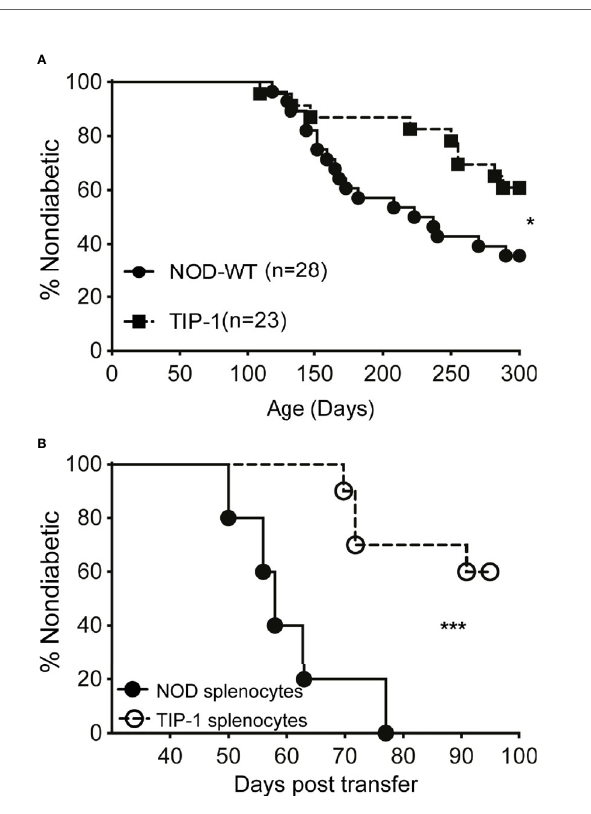
FIGURE 3 | Spontaneous diabetes incidence in TIP-1 mice (A) Incidence of spontaneous diabetes in female TIP-1 mice and non-transgenic littermates until 300 days of age. Numbers in parentheses indicate the number of mice analyzed. (B) Incidence of diabetes following transfer of splenocytes (2 x 10 7 cells/recipient) from 13-17 weeks old non-diabetic TIP-1 mice or NOD mice into 8-9 weeks old NOD.Rag1 -/- recipients (n > 5 each). *P < 0.05; ***P < 0.0001. Survival curves were compared using log-rank (Mantel-Cox) matched control mice using respective I-A (g 7 ) and K d tetramers.